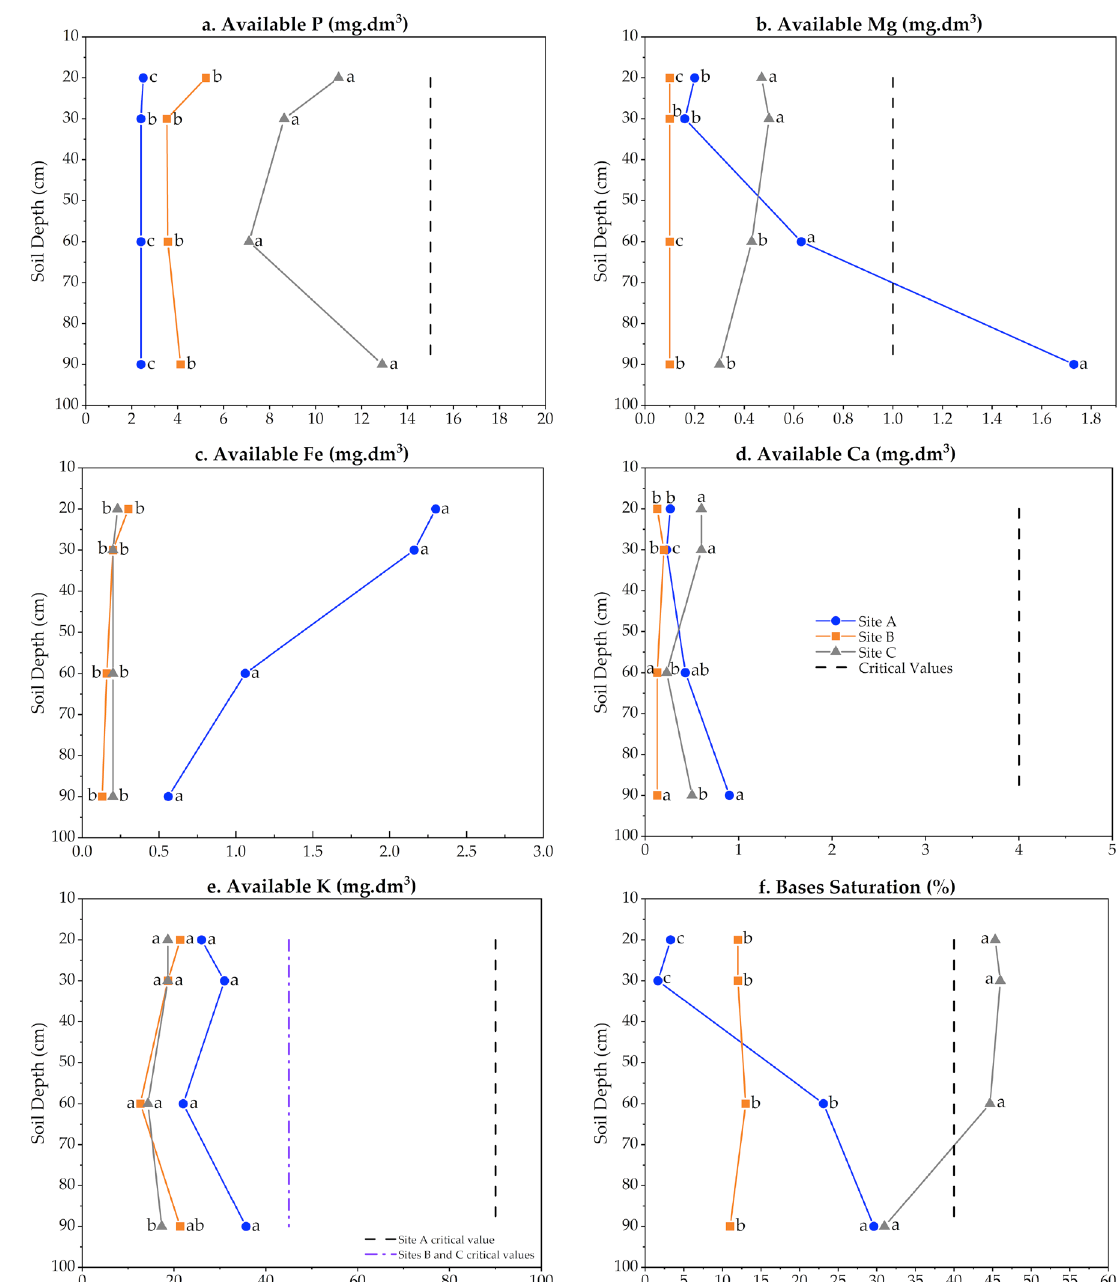
Figure 3. Mineral availability in soil from three different slash-pine plantations. Site A: 14-, Site B: 24-, Site C: 26-year-old slash pine plantations (age at the installation of the experiments). Each mean was calculated with ten combined samples from the same soil layer. Markers sharing a letter (within the same depth) are not significantly different by the Tukey test ( p ≤ 0.05). Site A: blue line; Site B: orange line; Site C: gray line. Critical values are shown as dotted vertical lines ( a , b , d , f ) or dashed-dotted vertical lines for Sites B and C ( e ) (CQFS-RS/SC 2016—Brazilian Soil Society, https://www.siabrasil.com.br, accessed 8 November 2022). In ( c ), critical values were not defined.